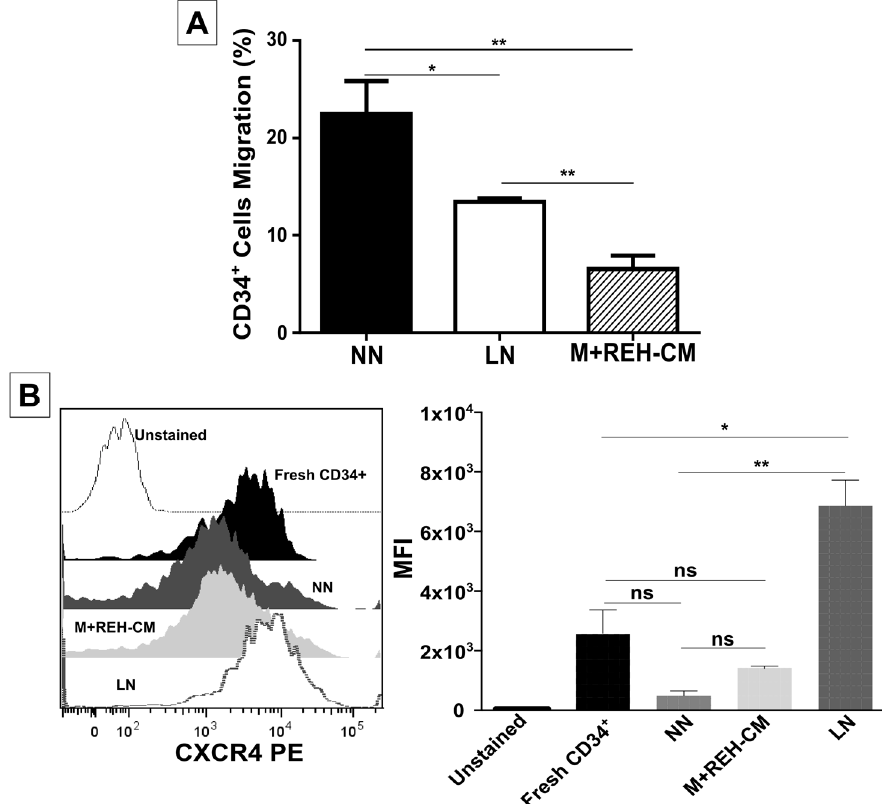
Figure 3. Decreased migration of CD34+ cells in a leukemic microenvironment. ( A ) The CD34+ cells migration capacity towards the chemoattractant SDF-1 was determined in a transwell system with a 5 μ m pore membrane; CD34+ cells from the NN or the LN and M + REH-CM CD34+ cells were allowed to migrate for 4 h, after which cells in the lower chamber were harvested and counted by flow cytometry. The percentage of migration was calculated considering the total input of CD34+ cells; ( B ) Labelling of CXCR4 (CD184) in freshly-isolated cells, NN, M + REH-CM, and LN CD34+ cells. Results are expressed as the median fluorescence intensity (MFI) from two independent experiments done in duplicates ( n = 4) (ns: non-significant, * p < 0.05, ** p < 0.01).